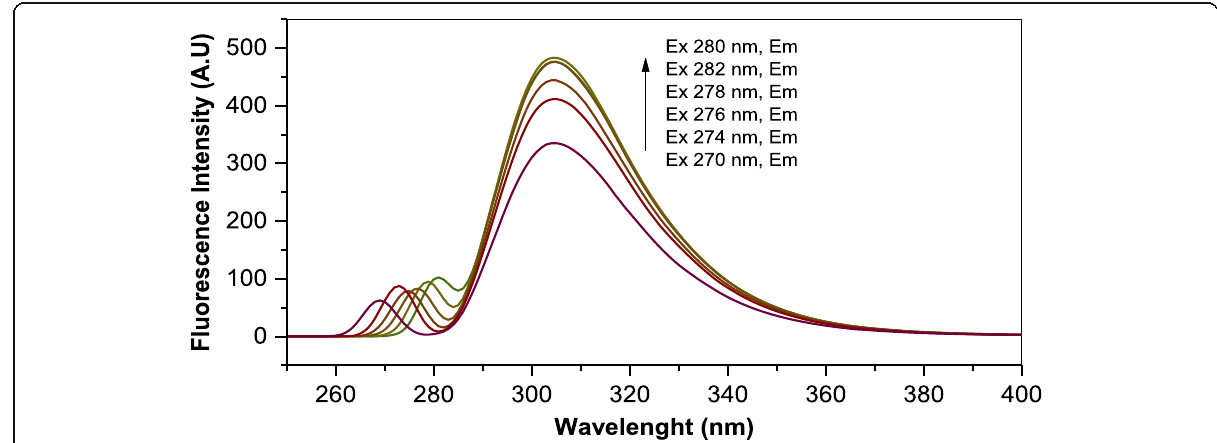
Fig. 2 The fluorescence intensity of INS in different excitation